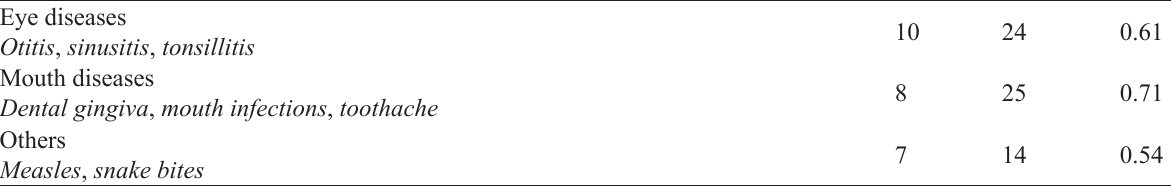
Table 4. Informant consensus factor for commonly used medicinal